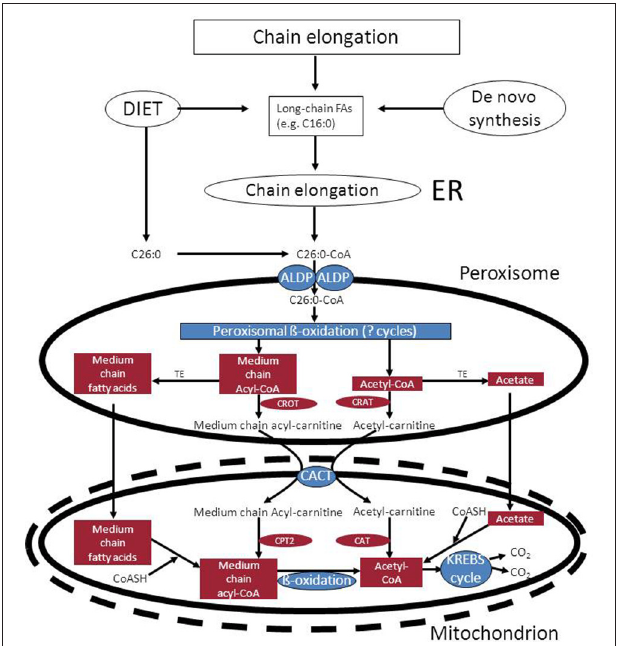
FIGURE 7 | Schematic diagram showing the key role of peroxisomes in the formation of C22:6 n-3. Doxosahexaenoic acid is synthesized from C18:3 n-3 which first undergoes a number of elongation and desaturation steps in the endoplasmic reticulum to produce C24:6-CoA which is then transported to the peroxisome and imported via a mechanism not yet resolved. Within peroxisomes C24:6-CoA undergoes one cycle of beta-oxidation to produce the corresponding C22:6-CoA which can then be exported out of the peroxisome for subsequent incorporation into lipids in the endoplasmic reticulum or may undergo additional sequential rounds of oxidation in peroxisomes and mitochondria. See text for more detailed